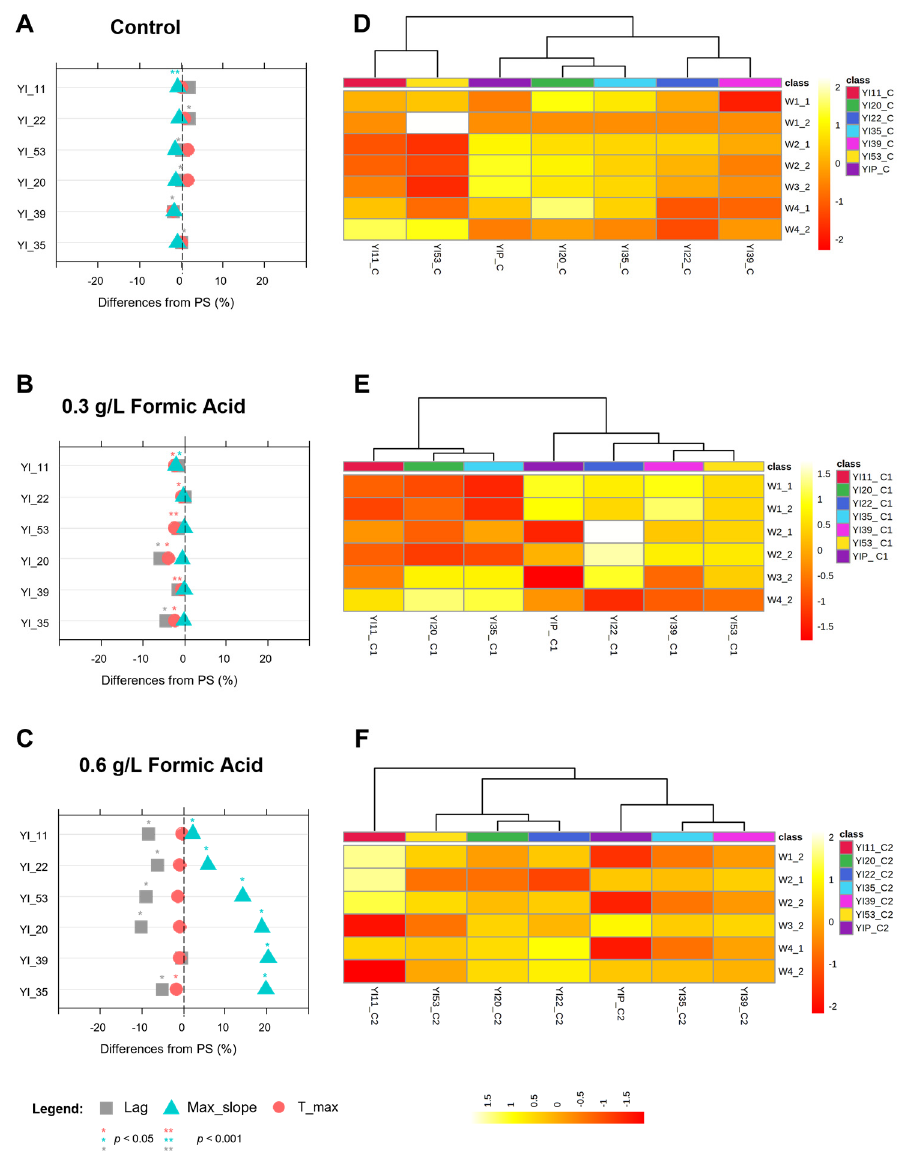
Figure 7. Growth and metabolomic phenotypes of YI30 S. cerevisiae parental strain and its derived MSCs during growth at increasing concentrations of formic acid (0.3 and 0.6 g L − 1 ). Panels ( A – C ): Lag time (grey square), max_slope (light blue triangle) and t_max (light red circle) parameters reported as percentage difference respect to the parental strain. Panels ( D – F ): Heatmap of the significantly altered FTIR peaks (distance measure using Euclidean, and clustering algorithm using ward.D). The coloured boxes indicate the relative intensities of the mean of peaks in the corresponding spectral region. The colour scale is log2 transformed value and indicates relatively high (yellow) and low (red) peak intensities. Spectral regions have been divided into sub-regions, namely: Fatty acids (W1_1 from 3200 to 3100 cm − 1 –W1_2 from 3098 to 2801 cm − 1 ); Amides (W2_1 from 1800 to1649 cm − 1 –W2_2 from 1647 to 1501 cm − 1 ); Mixed region (W3_1 from 1499 to 1352 cm − 1 –W3_2 from 1350 to 1202 cm − 1 ); Carbohydrates (W4_1 from 1200 to 1053 cm − 1 –W4_2 from 1051 to 902 cm − 1 ).